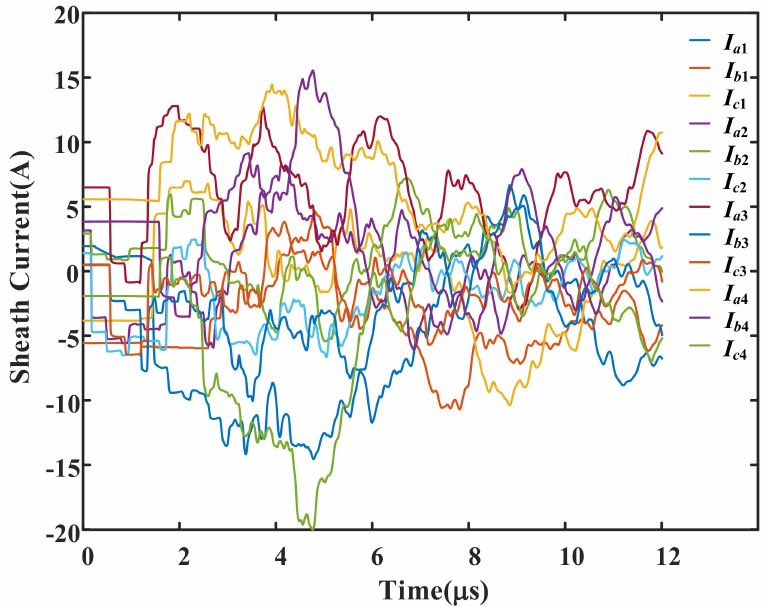
Figure 5. The simulated 12 sheath currents of the HV